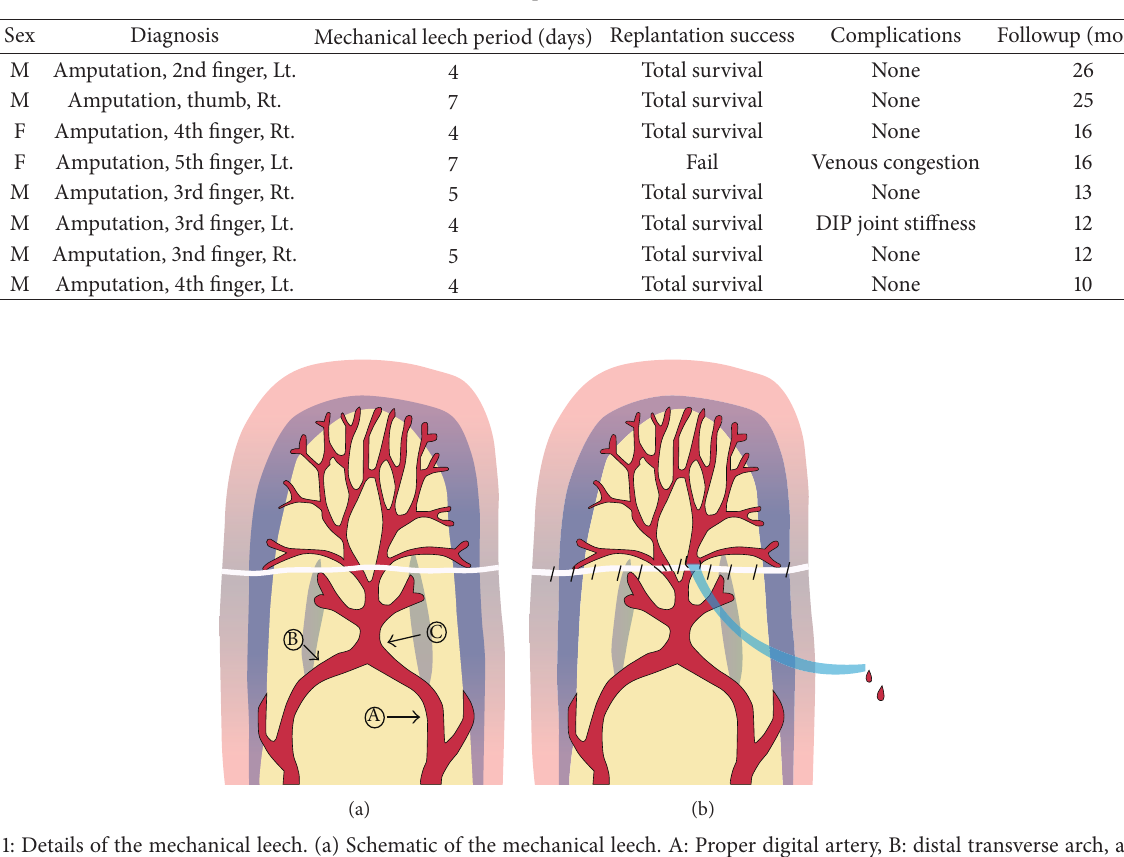
Table 1: Detailed patient characteristics.